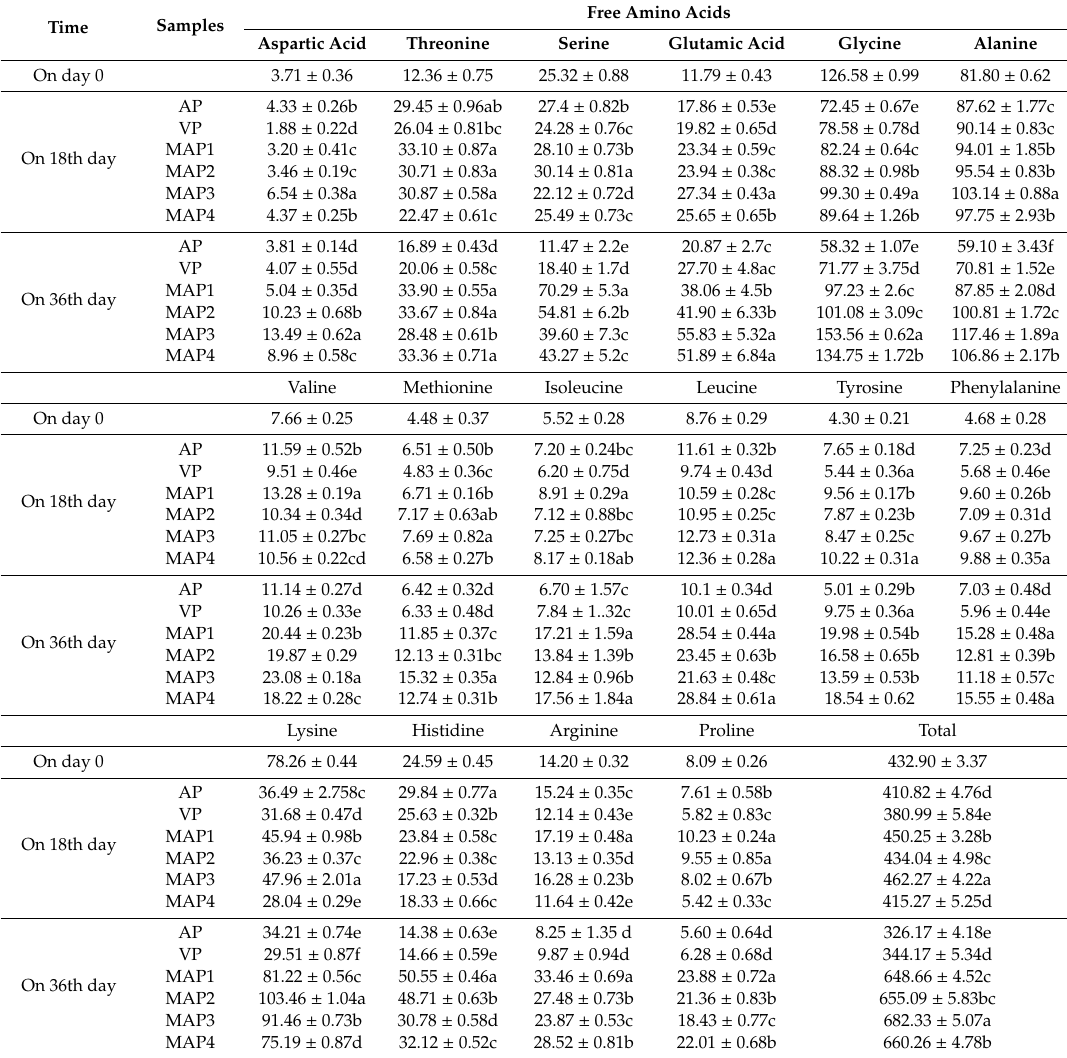
Table 1. Changes in the free amino acid content of Chinese sea bass during superchilling storage at − 0.9 ◦